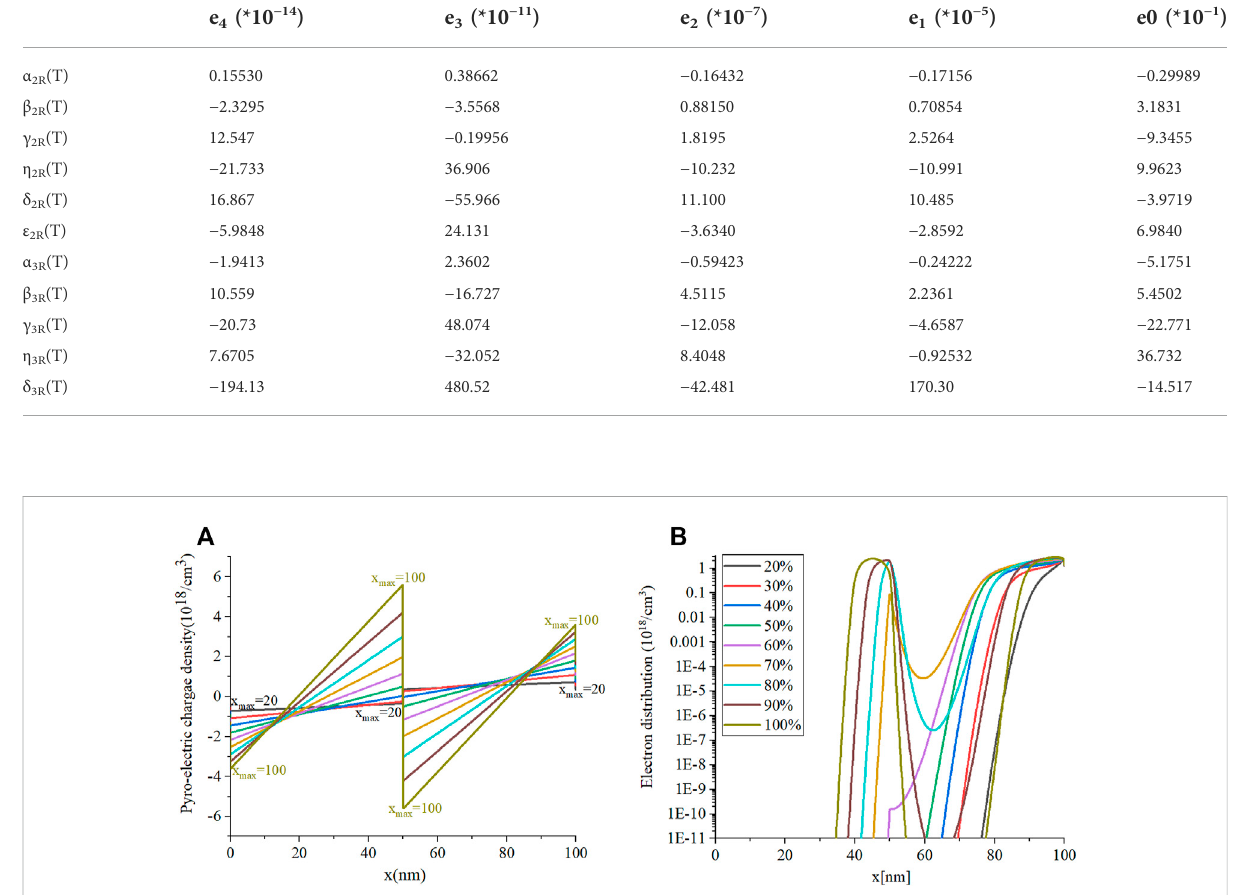
TABLE 8 Fitting parameters for α 2 , 3 , β 2 , 3 , γ 2 , 3 , and δ 2 , 3 under the relaxed